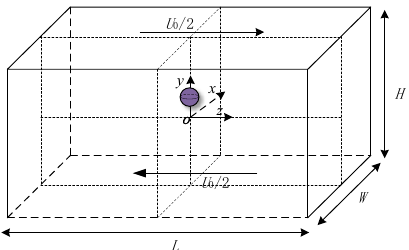
Figure 1. Diagram of 3D-confined flow and the coordinate system.